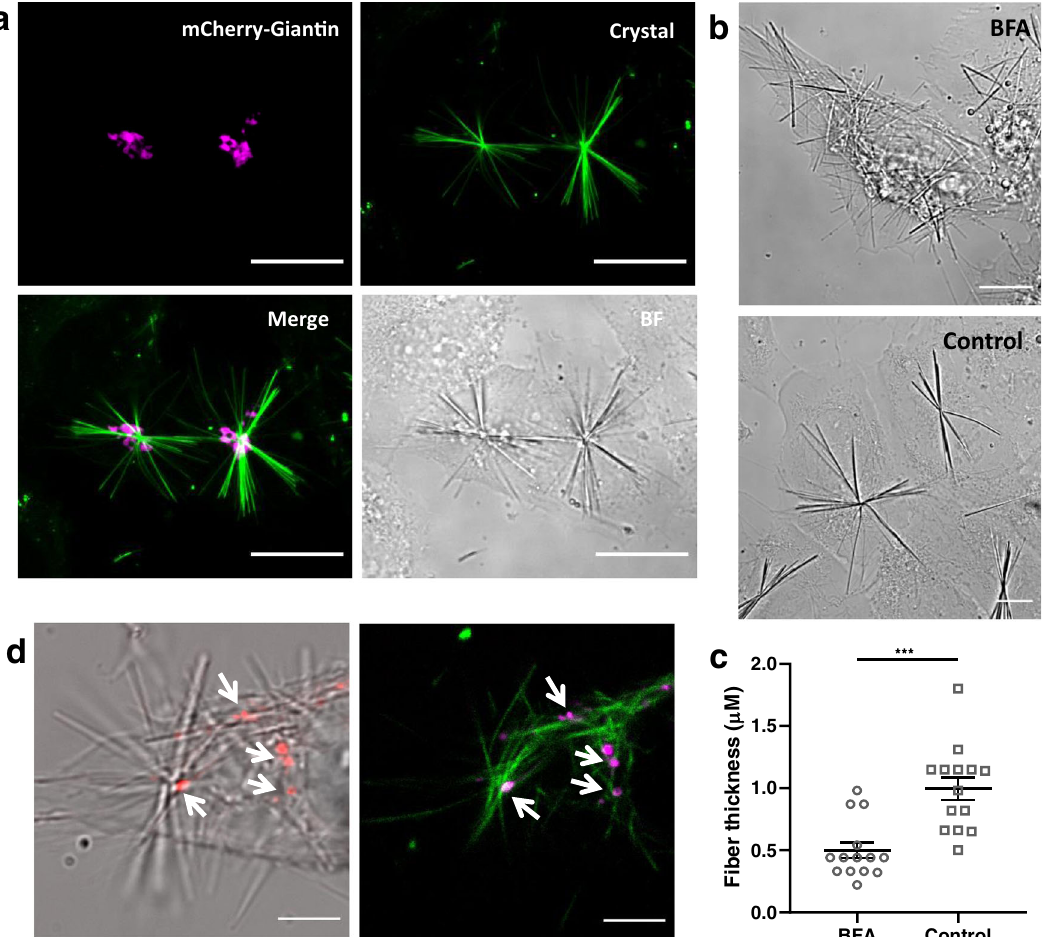
Fig. 4 The nucleation center of the QPD crystals is localized at the Golgi apparatus. a Representative images of mCherry-Giantin transfected U2OS cells treated with QPD-OTf (20 µ M 3 h). Crystals (green), mCherry-Giantin (magenta). Scale bar 20 µ M. b Representative images showing the effect of brefeldin A (BFA) on crystal morphology and location. BFA treated cells (20 µ M BFA 4 h + 20 µ M QPD-OTf 2.5 h) (top). Control (20 µ M QPD-OTf 2.5 h) (bottom); scale bar 10 µ M. c Quanti fi cation of images reported in b ; n = 14 fi bers; data are presented as mean value ± the standard error of the mean (SEM); statistics were calculated using a two-tailed t -test; *** p = 0.0001. d Localization of crystals and Golgi vesicles after BFA treatment; Golgi (red) crystals (bright fi eld) (left); Golgi (magenta) crystals (green) (right); arrows indicate centers of crystal; scale bar 5 µ M. Source data are provided as Source Data fi